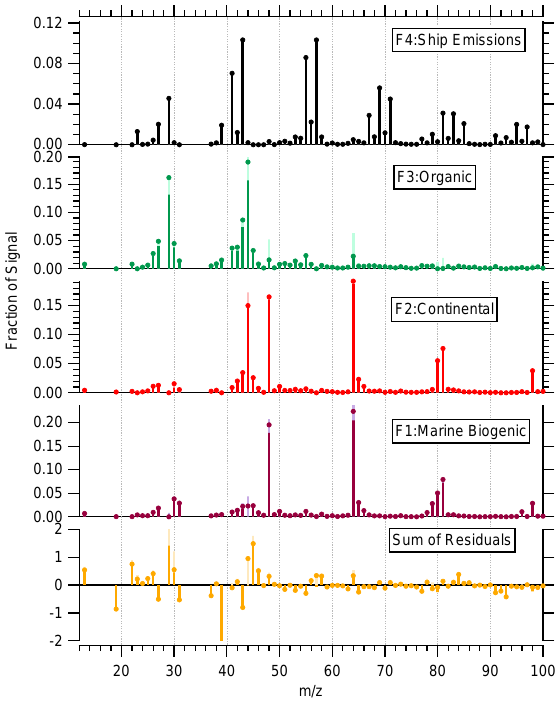
Fig. 4. Mass spectra of the PMF factors when performed on the entire mass spectrum. The circle represents the solution for an fPeak of − 0 . 75, and the light and solid bars the range for fPeaks of − 1 . 5 to 0. The signal is adjusted so that the sum of the signal for each mass spectrum is one.